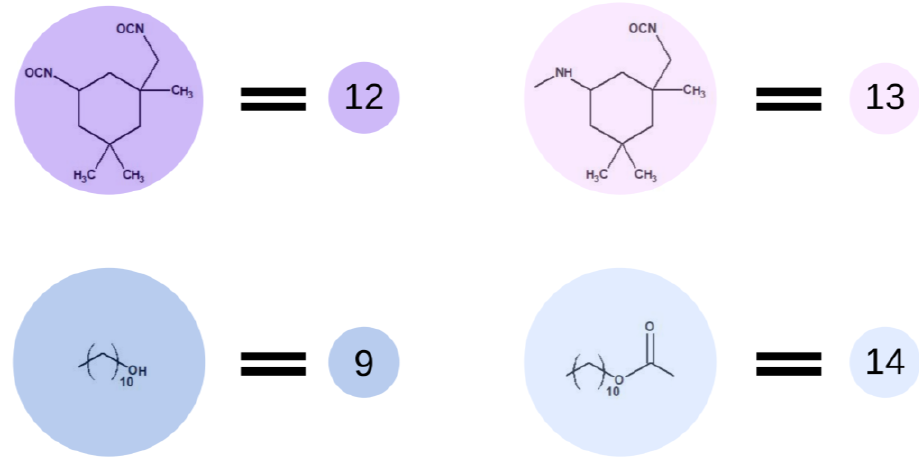
Figure 6. Schematic representation of the base unit participating in the prepolymer synthesis.